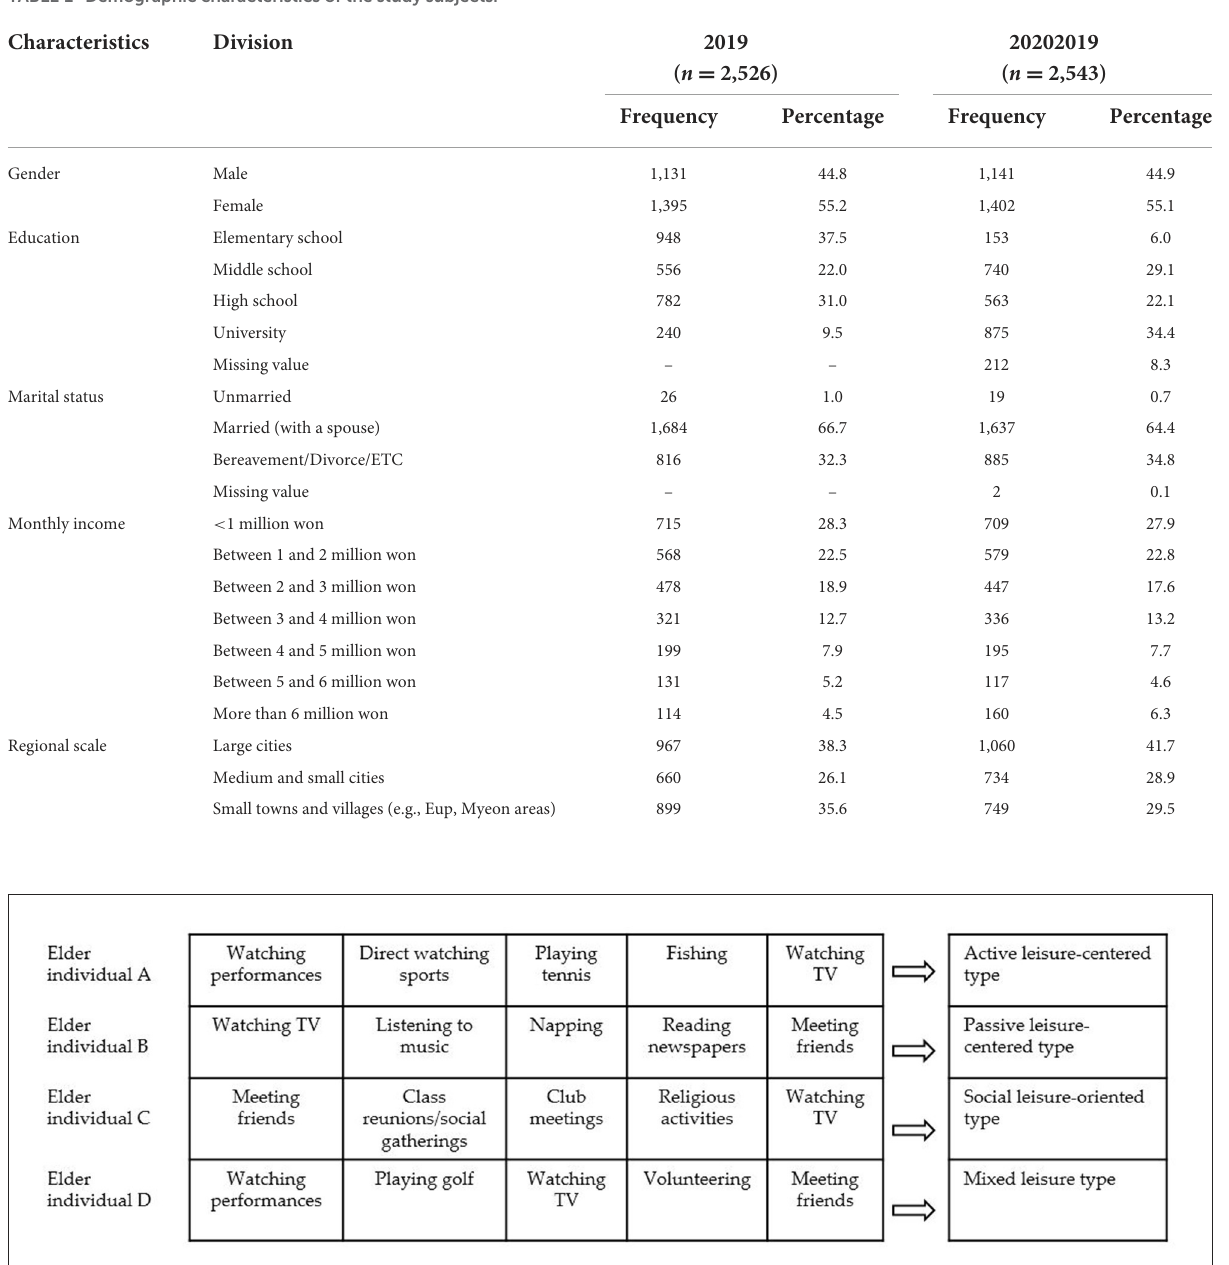
TABLE 1 Demographic characteristics of the study subjects.